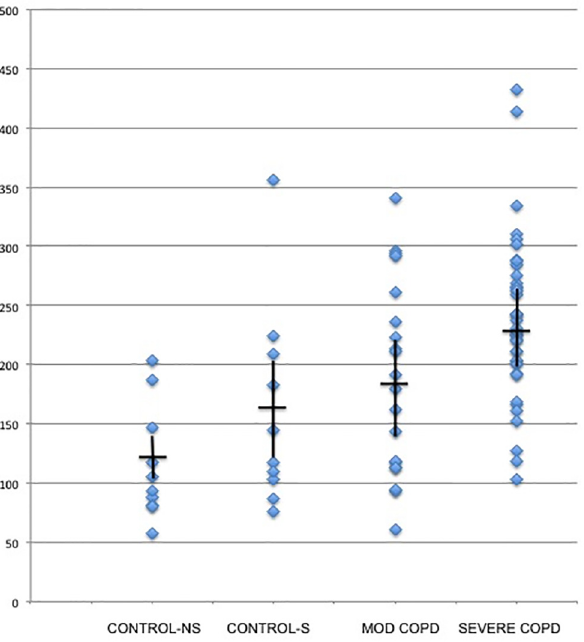
Fig 1. Peptide analyte intensities of BALF samples. p = 9.526e-05 (Kruskal-Wallis) for differences among the groups. Moderate COPD (GOLD 2), Severe COPD (GOLD 3 –